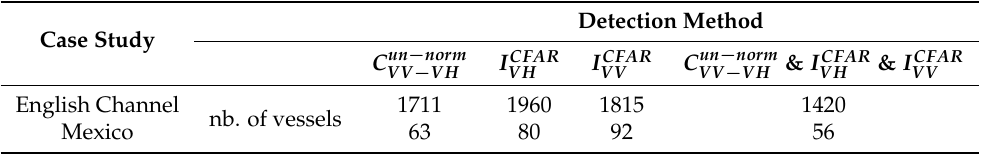
Table 3. SAR detections: coherence based detections and constant false alarm rate (CFAR) vertical transmission with vertical (VV) and horizontal reception (VH) Intensity detections.